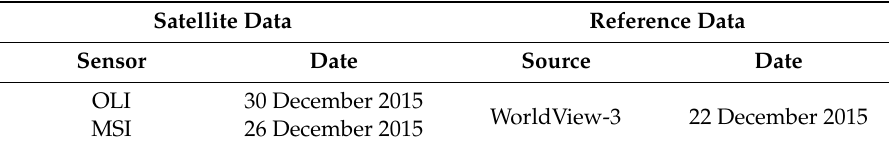
Table 2. Description of S2, L8 and the reference WV3